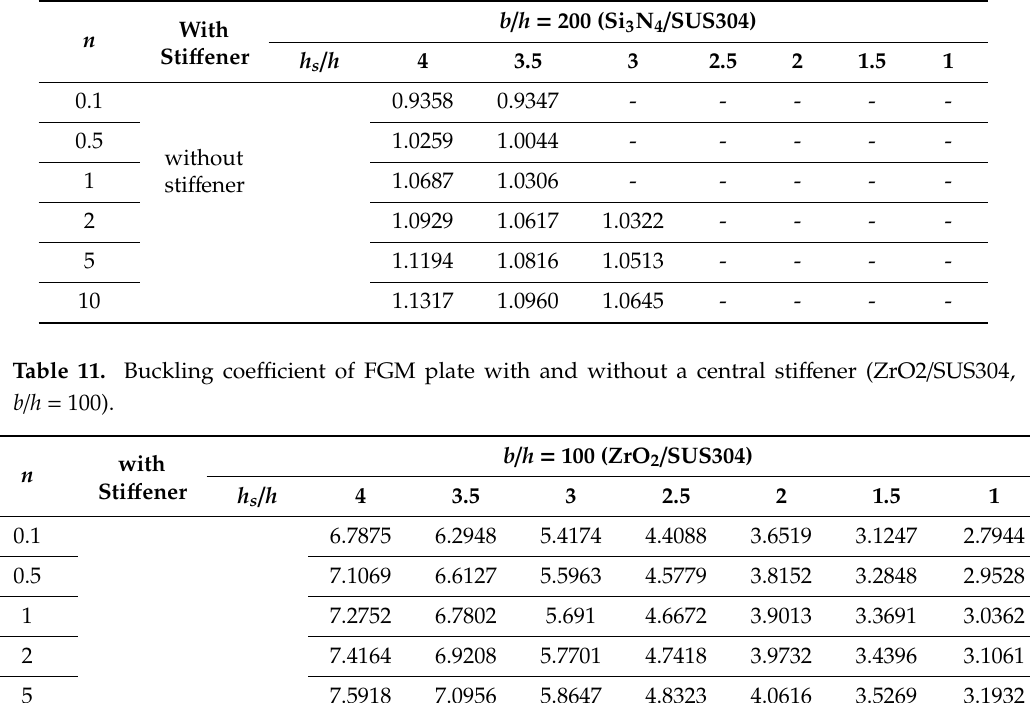
Table 10. The mass reduction between Si 3 N 4 / SUS304 plate with and without a central sti ff ener ( b / h = 200).